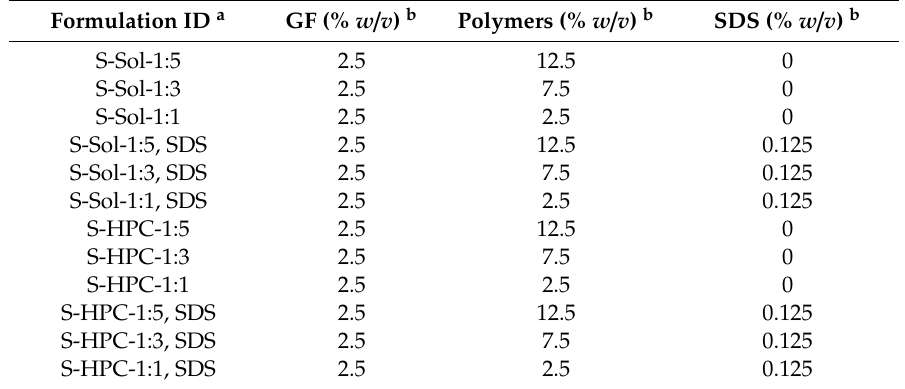
Table 2. Formulations of the griseofulvin–hydroxypropyl cellulose / Soluplus (GF–HPC / Sol) solutions with or without SDS fed to the spray